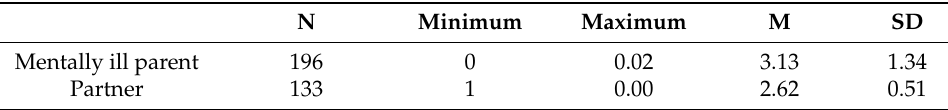
Table 2. GSI-BSI of parental psychiatric symptomatology.